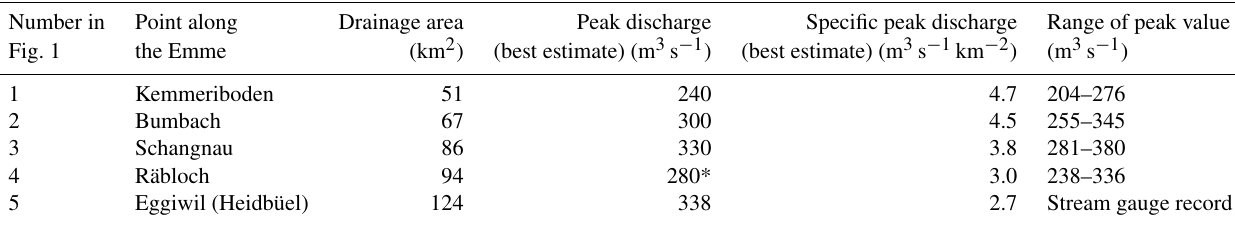
Figure 1. Location of the basin in central Switzerland. The coordinate system used was CH1903 / LV03. (a) Hill shade of the upper Emme River basin (up to Eggiwil); red dots show the location of the rain gauges (I: Kemmeriboden; II: Marbachegg; III: Schallenberg), and blue lines show the 19 streams analyzed (18 tributaries and the main river Emme). (b) Land use. Agr.: agriculture; rock: bare soil; forest; bush: shrubs and bushes. (c) Geology: 1 Quaternary and Neogene molasses; 2 moraines; 3 Paleogene flysch; 4 Cretaceous and Jurassic sedimentary rocks. (d) Debris flood and LW deposits in the lower part of the Sädelgrabe torrent upstream of the small road bridge and its confluence with the Emme River (photograph: Virginia Ruiz-Villanueva). (e) Road and bridge washed away during the flood in Bumbach (photograph: Virginia Ruiz-Villanueva). (f) Räbeli bridge damaged during the flood (photograph: Virginia Ruiz-Villanueva). Numbers from 1 to 5 (a) show the cross sections described in Table 2. Arrows (d, e, f) show the flow direction. Table 2. Peak discharges along the Emme during the 24 July 2014 flood, measured or estimated in the framework of the local event analysis for several sites along the Emme River (data source: ARGE LLE Schangnau-Eggiwil, 2015). Note that the drainage area given here does not precisely correspond to the data in Table 2 because estimates were carried out for which flood marks were available. The locations of these sites are shown in Fig.